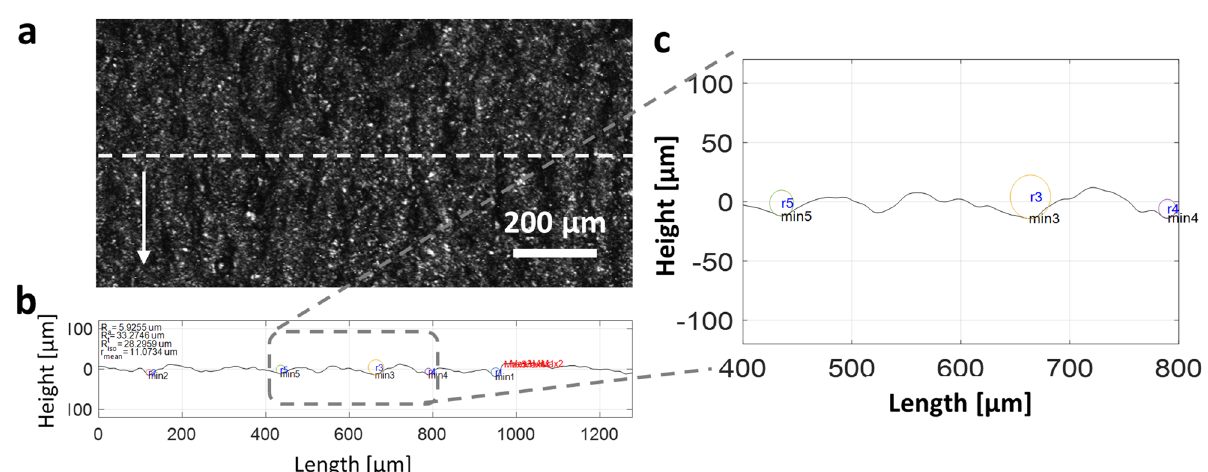
Figure 6. (a) The surface of a typical sample built at laser speed 1250 mm/s. The surface image was taken after blasting. (b) The line profile of the dashed line in (a) . (c) Enlarged line profile of the selected area in (b) . The circles represent the radius of the curvature in the deepest